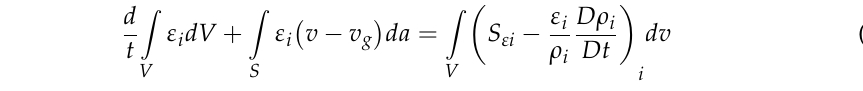
Figure 7. Calculation domain diagram: ( a ) Internal computing domain and ( b ) external computing domain.